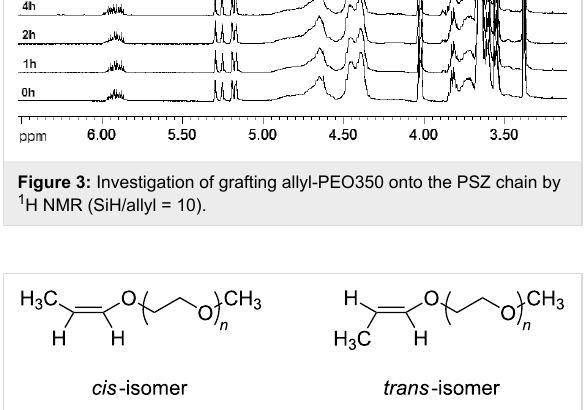
Figure 4: Chemical structure of cis - and trans -isomers of allyl-PEO.